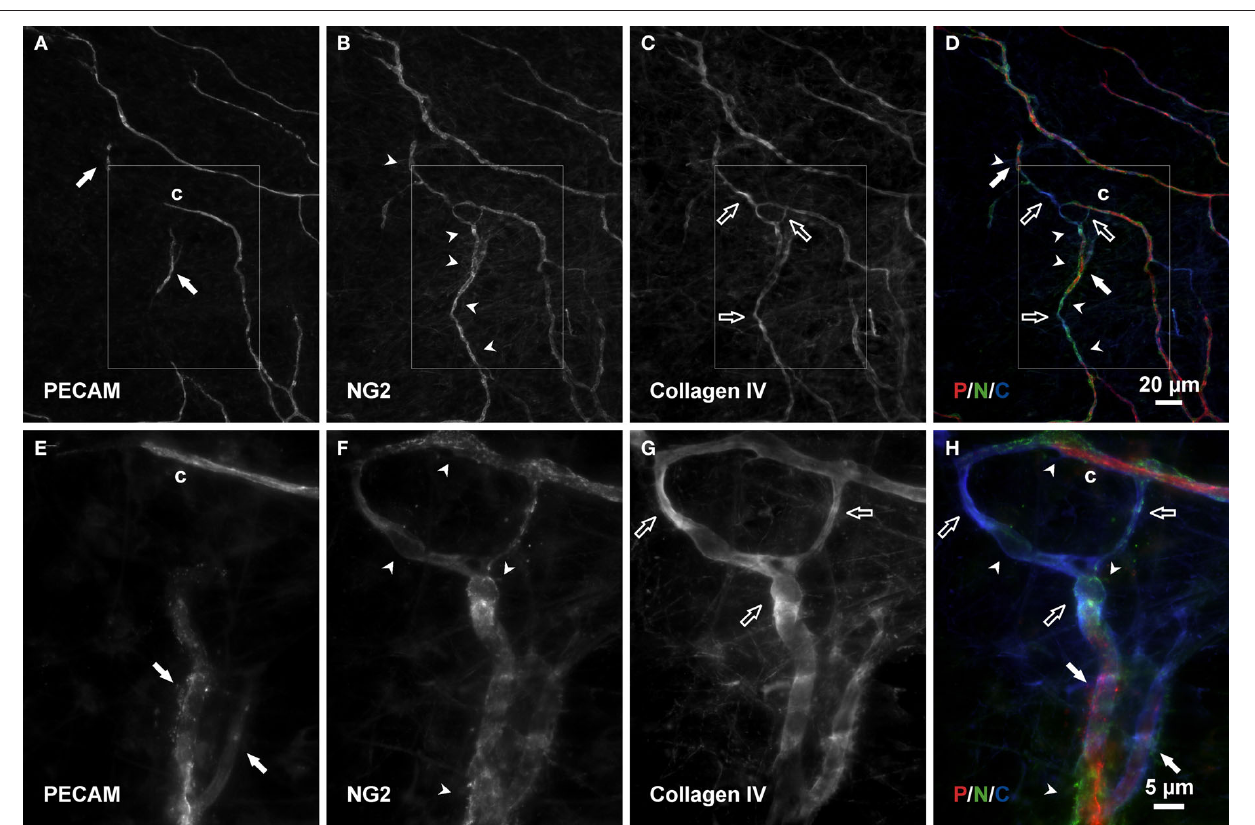
FIGURE 7 | Connecting basement membrane tracks contain pericytes. (A–D) Examples of PECAM positive endothelial cells along a vascular island (filled arrows) connected to a nearby vessel segments via an NG2/collagen IV track. Arrowheads indicate pericytes; open arrows